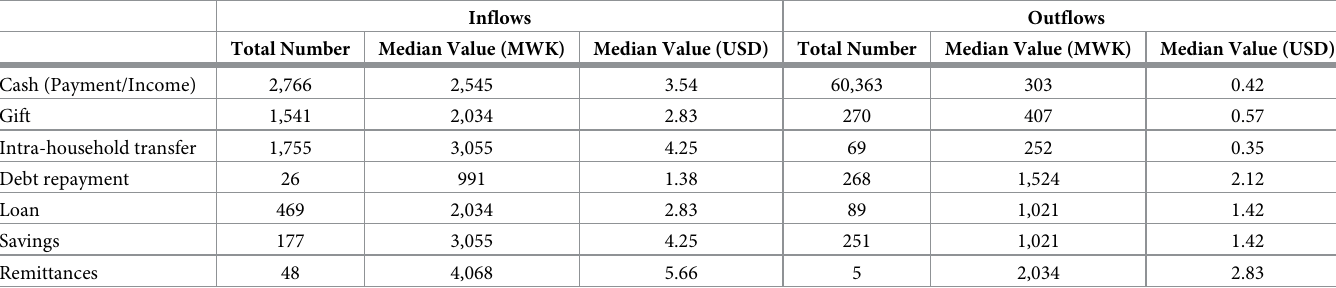
Table 4. Overview of cash inflows and outflows by transaction